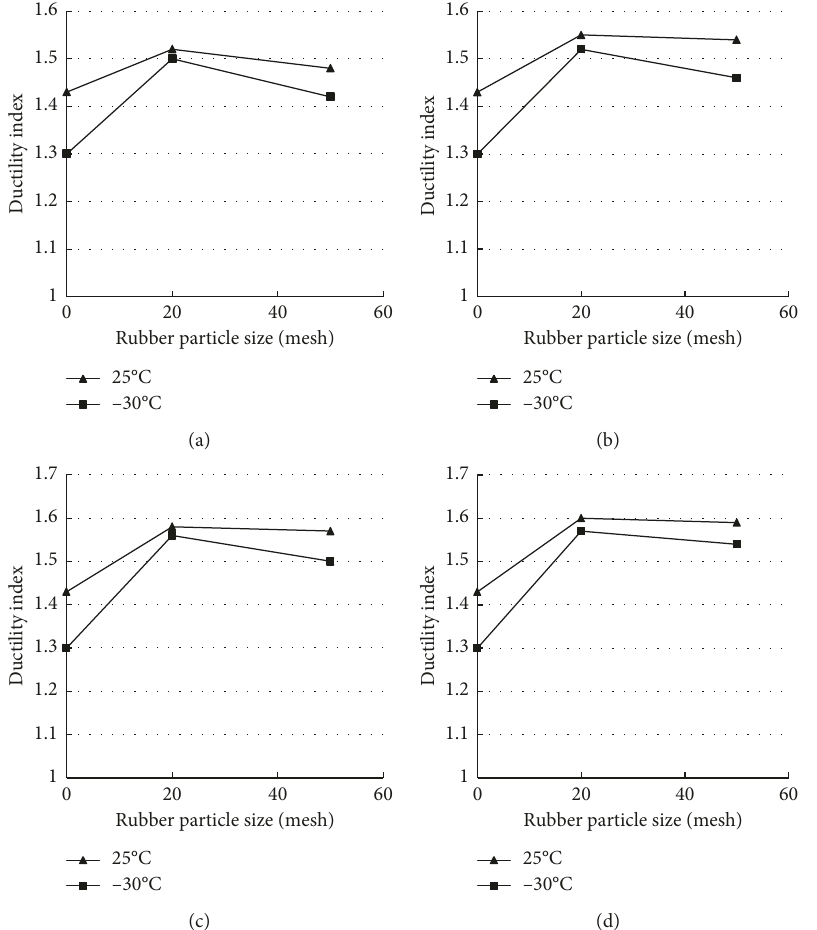
Figure 4: Relationship between the rubber particle sizes and the ductility indexes of the concrete specimens. Rubber content: (a) 5%, (b) 10%, (c) 15%, and (d)